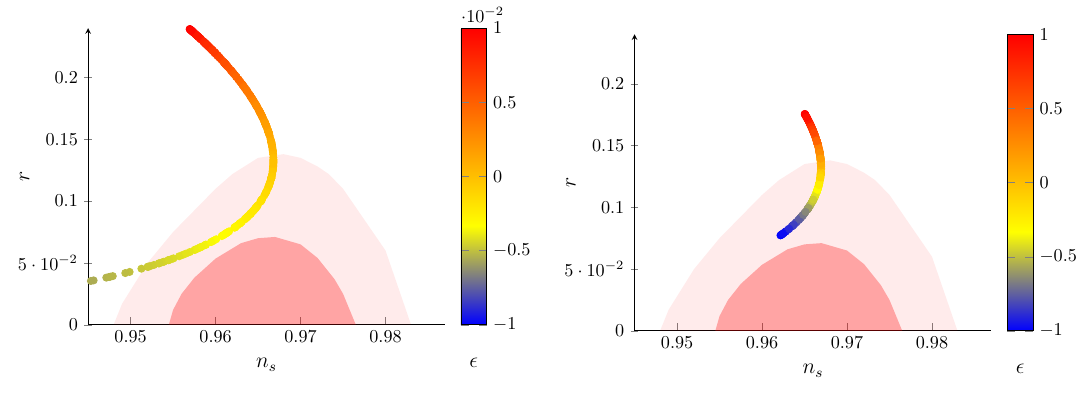
Figure 2 . Scan over the parameters (cid:22) (cid:30) = [10 10 ; 10 12 ] GeV and in two di(cid:11)erent cases: the scenario where the critical point stands at small values ( (cid:30) c = 1 M p , left panel) or large values ( (cid:30) c = 30 M p , right panel), corresponding respectively to the cases 1. and 2. enumerated in the text. Light red regions correspond to the 1 and 2 sigma exclusion limits released by the Planck collaboration ([44], Planck